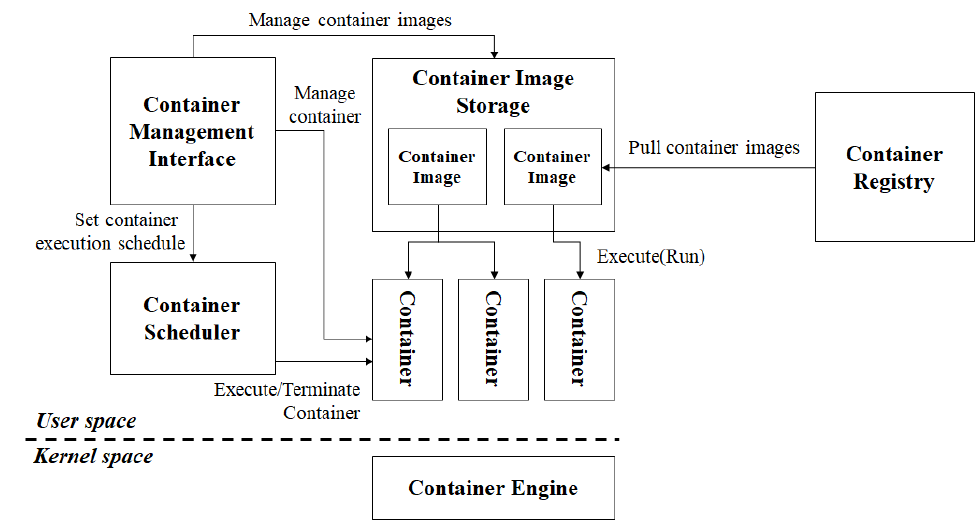
Figure 1. Container platform structure.